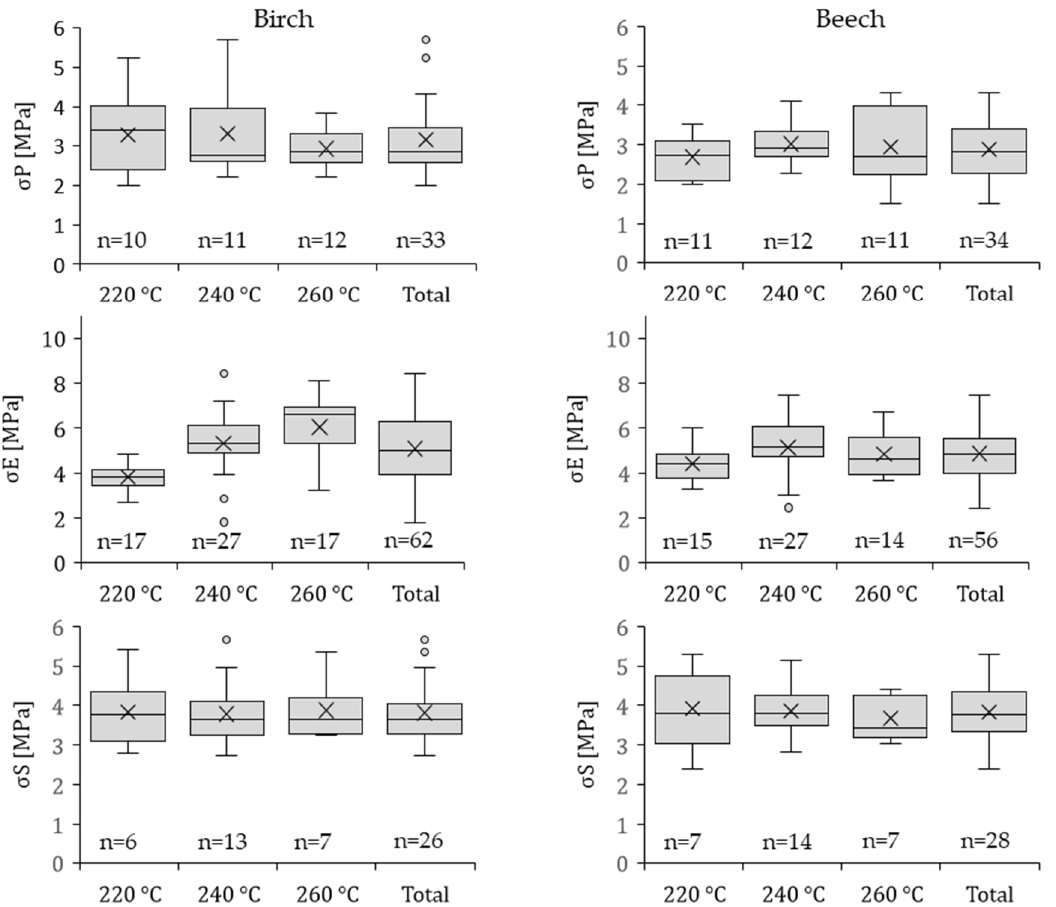
Figure 5. Strength properties of 121 birch plywood specimens and 118 beech plywood specimens overmolded with PP at three different injection temperatures. σ P is the average tensile strength perpendicular to the plane of the board, σ E is the average tensile strength perpendicular to the edge, σ S is the average tensile shear strength and n is the number of the samples tested. The whiskers show minimum and maximum values. X is the mean value. ° indicate values of statistical outliers and—is the median.